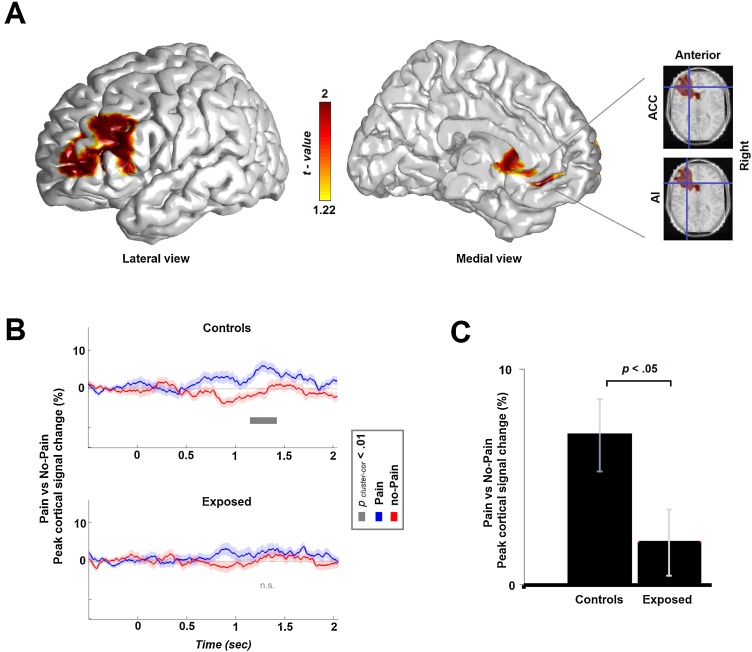
(A) Source-level localization of the gamma-band spectral pattern overlaid on MNI template. Color on the template represent peak statistical activity (p cluster-cor < 0.05) in the left-hemisphere, with orientations mentioned (e.g., lateral/medial, right, anterior). Virtual channel was extracted from the peak source location and averaged across the sensor-level frequency band, using the (B) LCMV and the (C) PCC beamformers. The first enables the representation of time-series in a specific cortical location, whereas the second localizes the source on the time samples of interest.